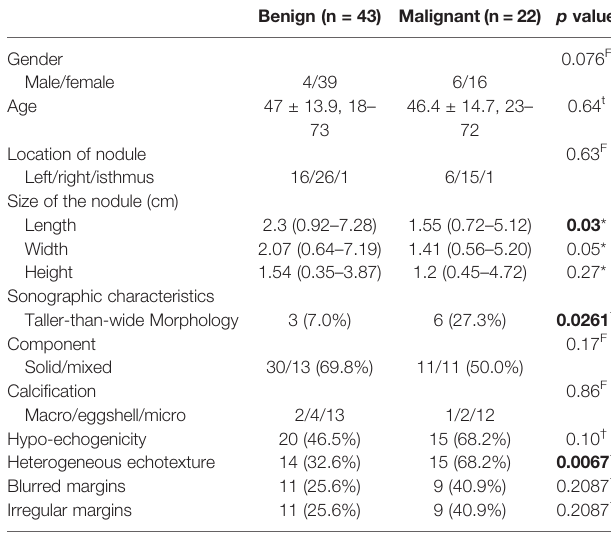
TABLE 1 | Demographic characteristics of patients diagnosed with follicular neoplasm on cytology. Characteristics